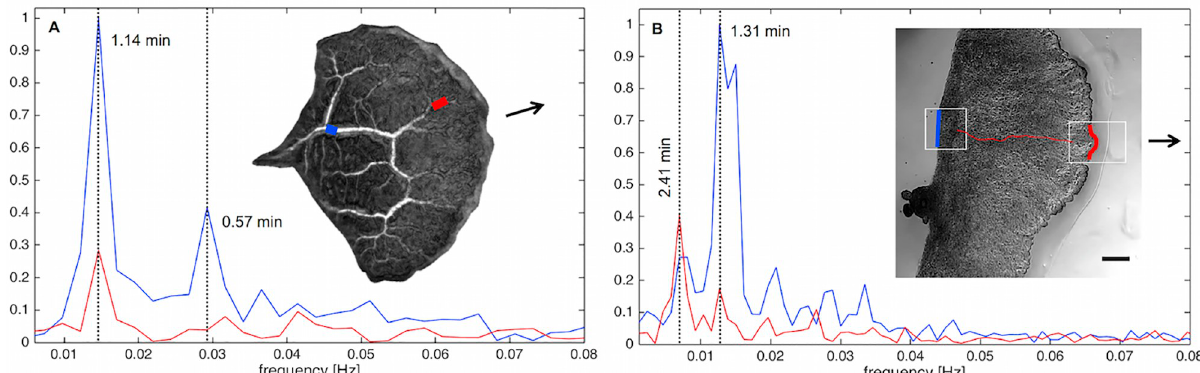
Fig 7. Fast Fourier transform (FFT) of mesoplasmodial oscillations. Examples of changing frequencies of endoplasm flow throughout a mesoplasmodium (A) and differences in the oscillation pattern between frontal and uroidal membrane (B). Arrows denote direction of movement. A) Data obtained from optical flow analysis. Blue denotes a segment in the back of the mesoplasmodium, red is a segment closer to the front. Whereas a frequency with a period of 1.14 min can be detected everywhere along the length of the vein (although getting less pronounced further away from the uroid), the higher frequency also present in the uroid (0.57 min) is filtered out towards the front. The mesoplasmodium as a whole shows area oscillations with a period of 0.62 min. B) Red = oscillations of the frontal membrane. Blue = oscillations of the uroidal membrane (see white boxes). Data obtained from